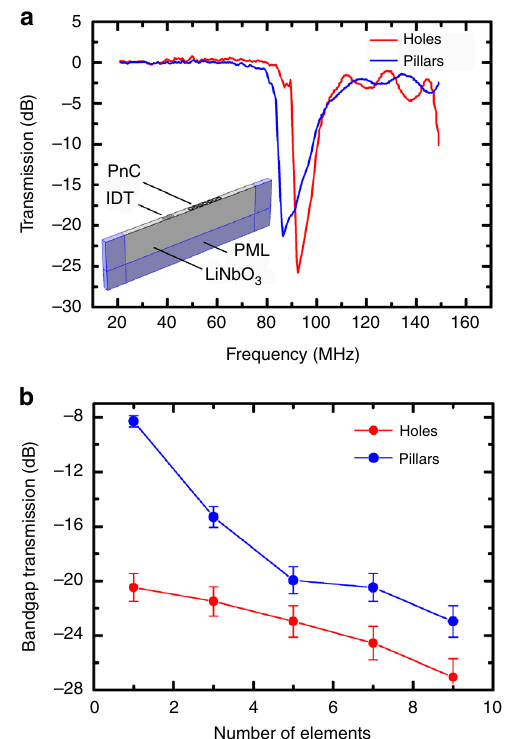
Fig. 2 Simulated SAW transmission for novel annular holes and typical pillars. a Transmission vs. frequency for SAWs showing a deeper bandgap dip in transmission through 7 annular holes compared to 7 pillars. Inset schematic shows the PnC, interdigital transducer (IDT), LiNbO 3 substrate and shaded perfectly matched layers (PML) of the simulation. b Bandgap transmission minimum for increasing number of elements in propagation direction with s.d. error